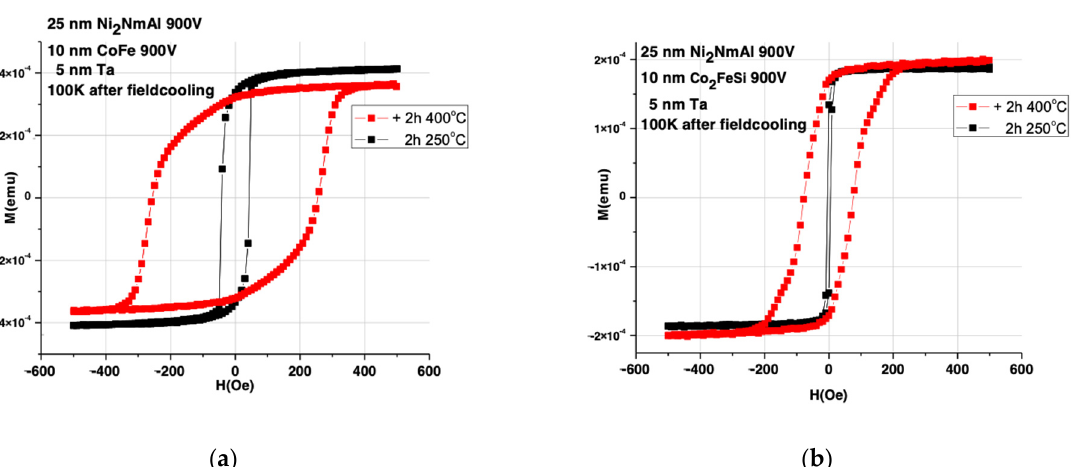
Figure 4. Magnetisation curves of the Ni 2 MnAl (25)/( a ) CoFe (10) and ( b ) Co 2 FeSi (10)/Ta (5) (thickness in nm) bilayer post-annealed at 250 and 400 ° C for 2 h under the field applications in the plane.